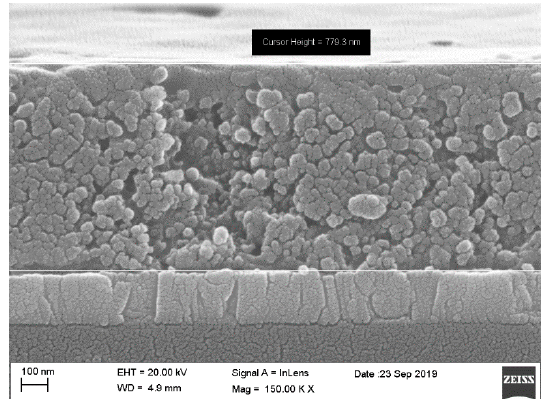
Figure 3. Cross-sectional field emission scanning electron microscopy (FESEM) image for the fabricated TiO 2 / 4T / P3HT solar cell.